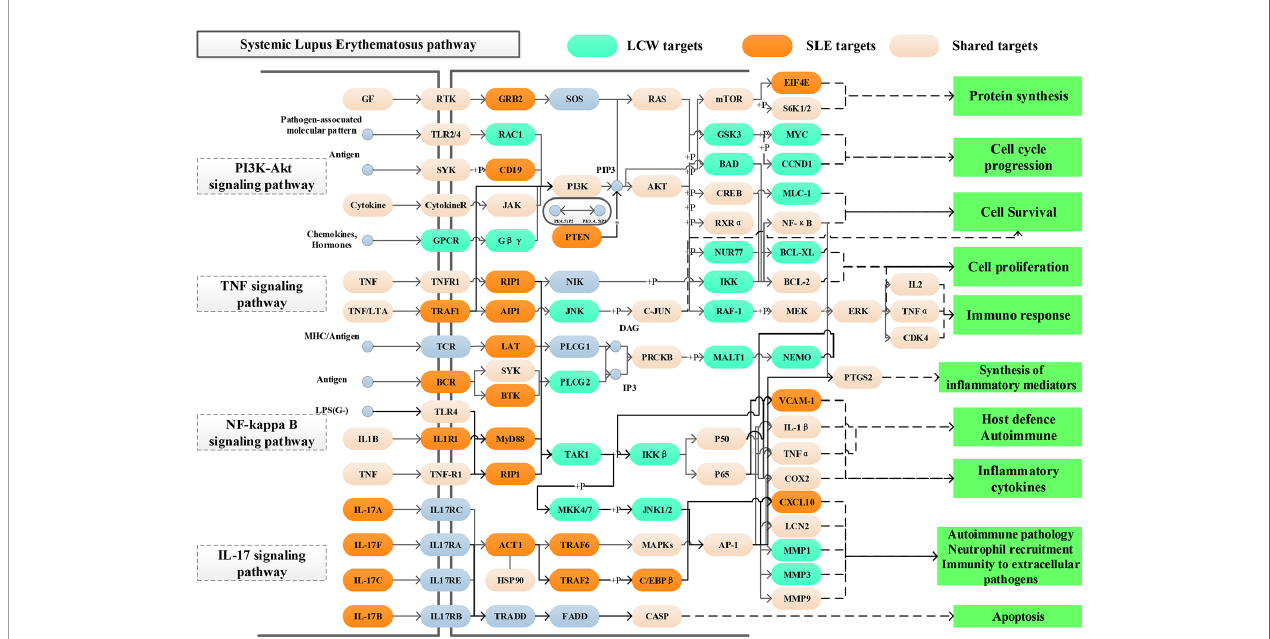
FIGURE 10 | Distribution of targets of KGEC on the comprehensive signaling pathway. Different colors represent different types of targets. Light green represents the targets of LCW, orange represents the pathogenetic genes of SLE, and pink represents shared targets,